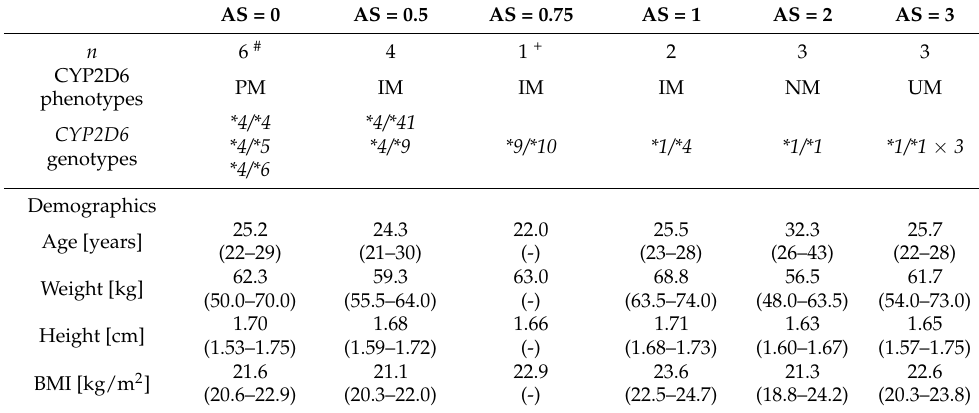
Table 1. Overview of clinical data integrated from the pharmacokinetic panel study.